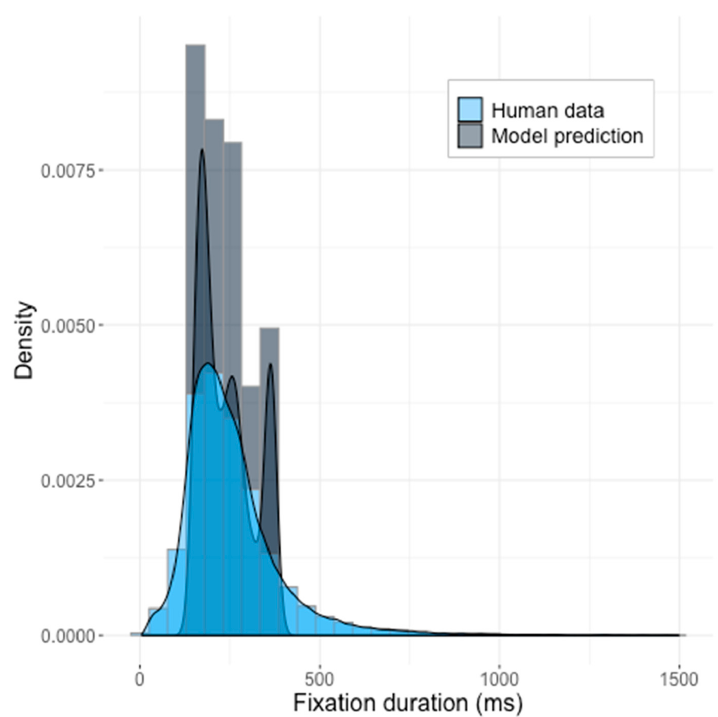
Figure 9. Saliency Model’s predictions with the fifth parameters space, learned on the 91 pictures dataset. The model generated ten initial saccades per image. Z-test statistics: z = 6.5611, p = 5.341 × 10 − 11 ; KS-statistics: D = 0.19327, p < 2.2 × 10 − 16 .